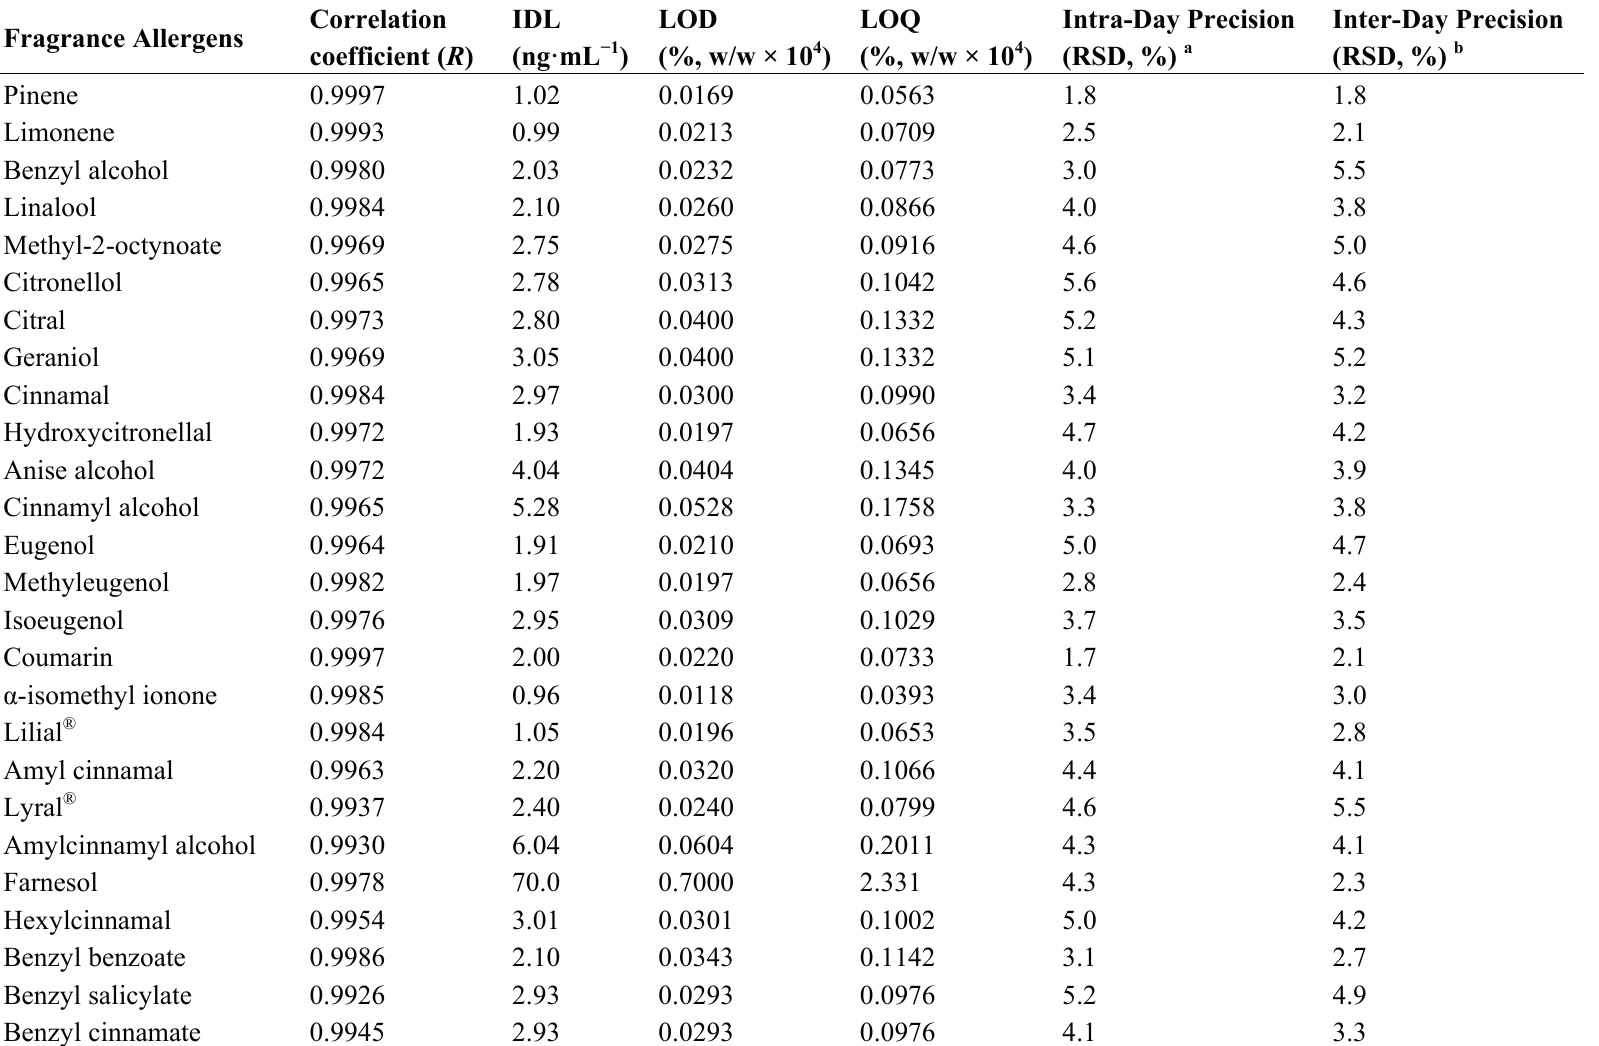
Table 3. Quality parameters of the